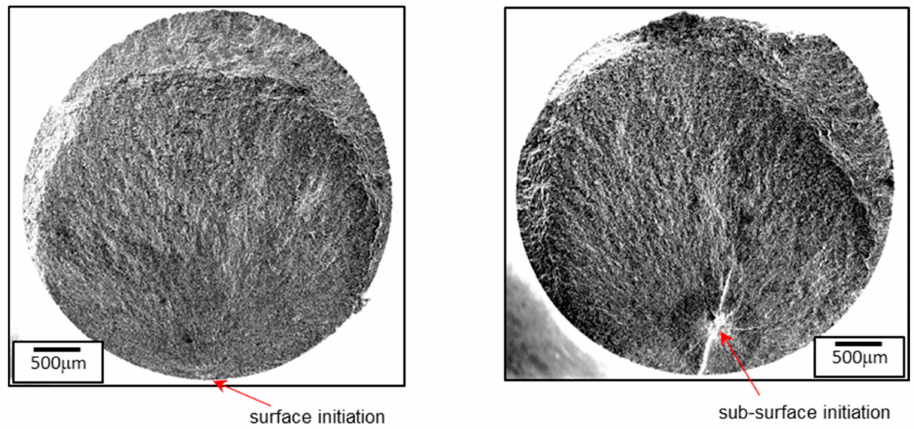
Figure 7. Examples of surface ( left ) and sub-surface ( right ) crack initiation sites in Ti-407 (scanning electron microscope